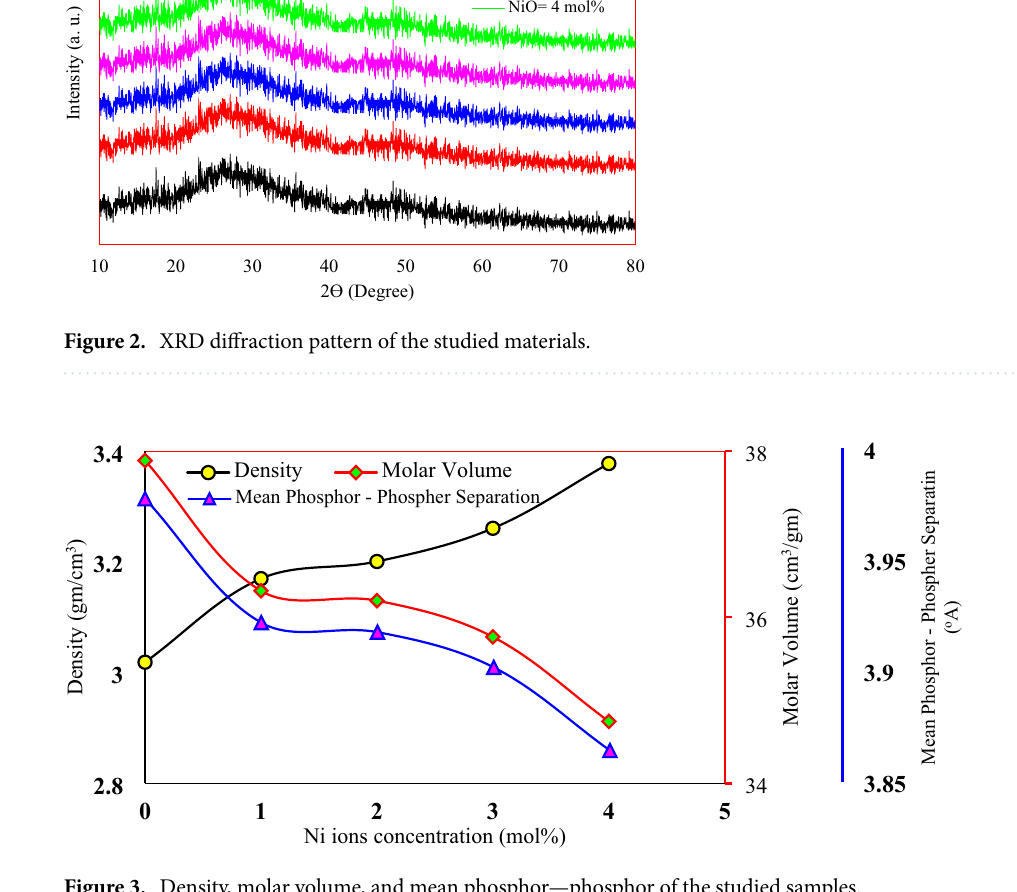
Figure 3. Density, molar volume, and mean phosphor—phosphor of the studied samples.